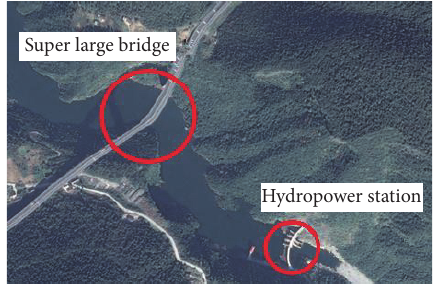
Figure 2: Position of Yesanhe Super Large Bridge and Yesanhe Hydropower Station.